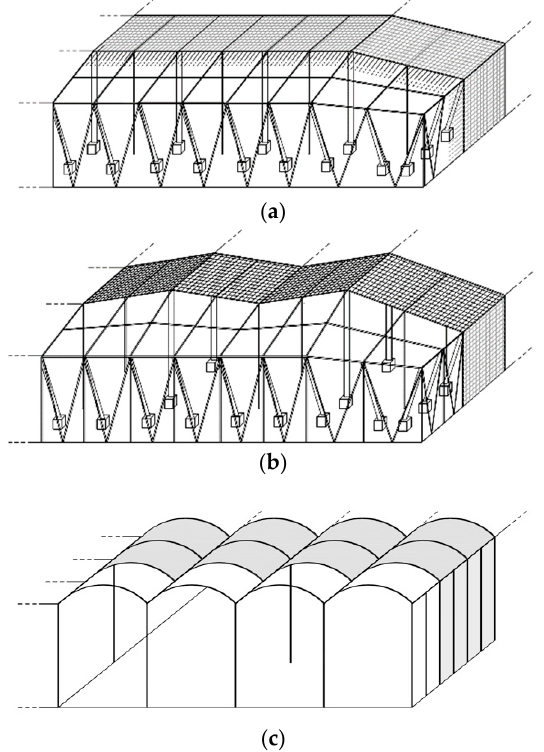
Figure 4. Greenhouse typology: ( a ) Flat-top greenhouse, ( b ) Almeria-type “raspa y amagado” greenhouse with gable roof, ( c ) semicylinder multi-span film-covered greenhouse.